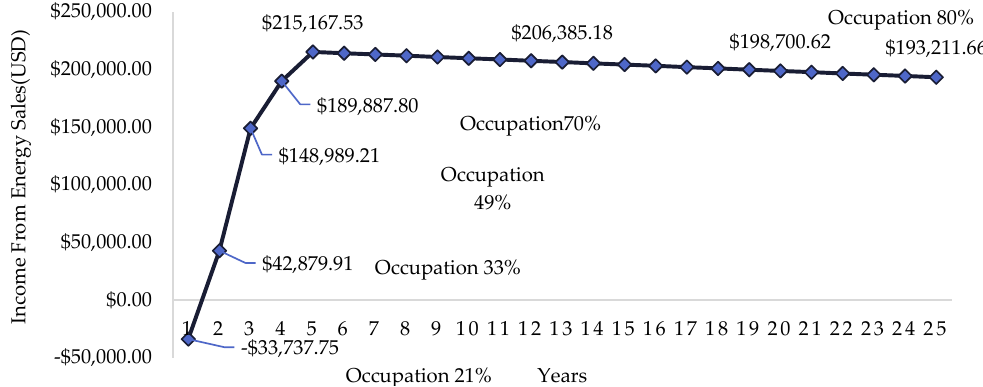
Figure 21. Projection of income according to percentages of occupation of cargo spaces.